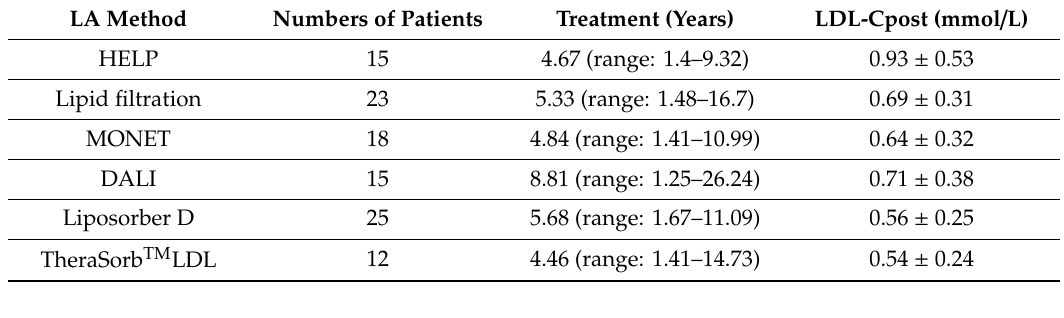
Table 3. Numbers of patients treated with an LA method in May 2019. Parameters which were significantly different are listed: duration of LA therapy (mean, range), LDL-Cpost (after the LA session in 2019; mean ± standard deviation) LDL-Cpost: only the HELP and die Liposorber D groups were significantly different (Bonferroni-test: p 0.020).